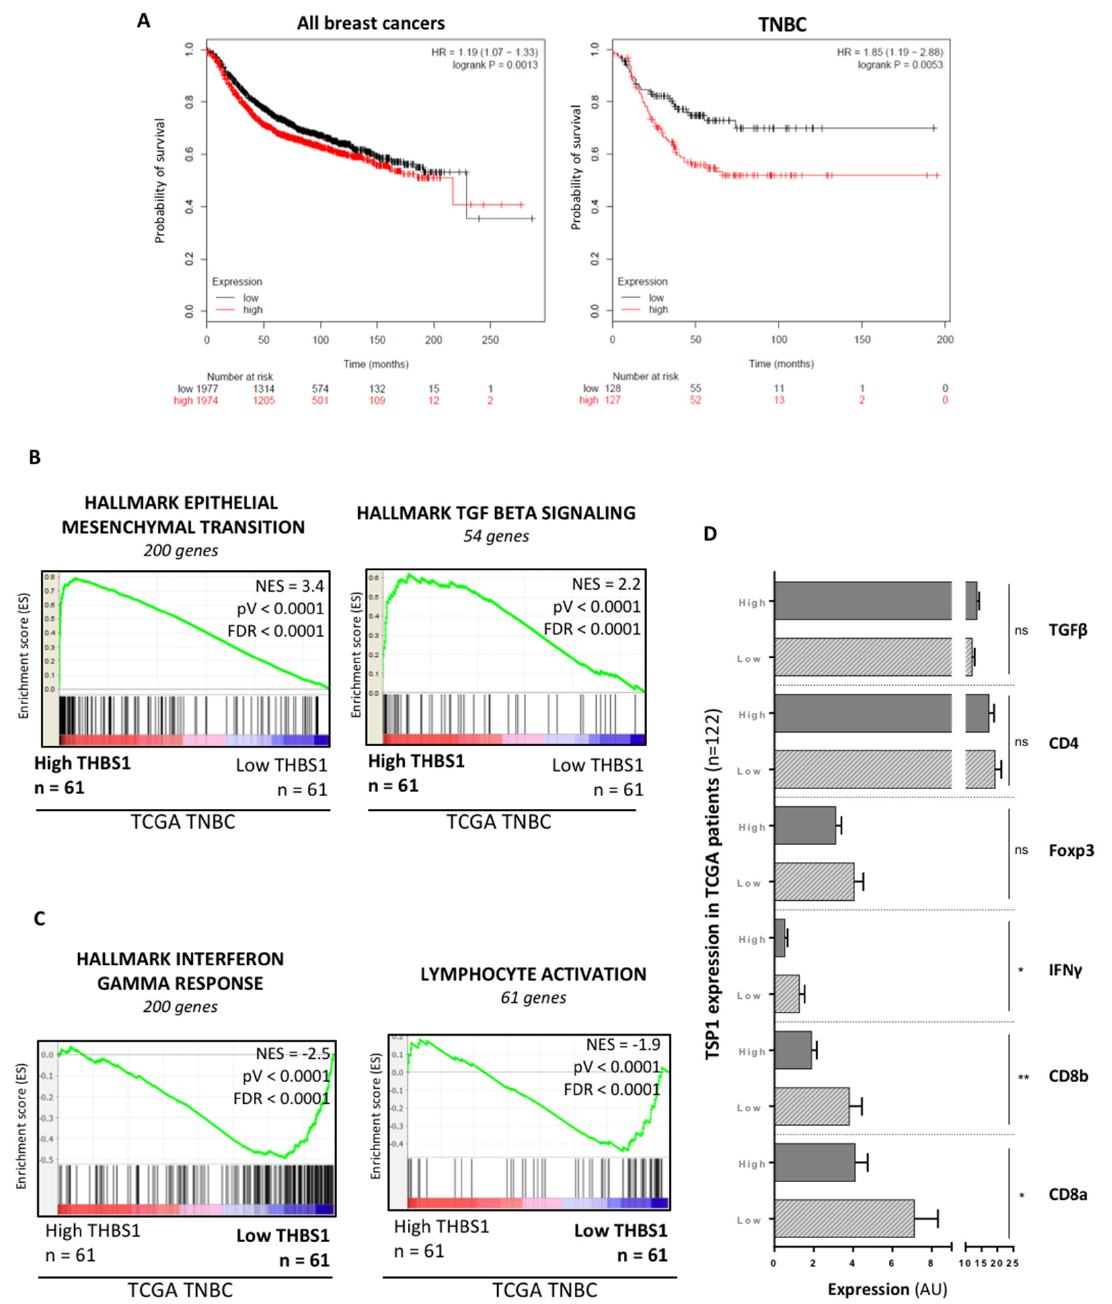
Figure 1. Impact of TSP1 expression on prognostic value in breast cancer. Schemes follow the same formatting. ( A ) Kaplan–Meier relapse-free survival analysis relating to TSP1 mRNA levels in 3951 breast cancer patients (left panel) and the same analysis in a cohort of 253 TNBC patients (right panel). Hazard ratios (HRs), 95% confidence intervals and log rank p -values are indicated in the graphs. ( B , C ) Gene Set Enrichment Analysis of gene signatures was performed from transcriptomes of the human TNBC TCGA database. Kolmogorov–Smirnov statistical test was performed. ( D ) mRNA expression in low and high TSP1 mRNA-expressing tumor samples from the human TNBC TCGA database. Mann–Whitney statistical test was performed. *, p < 0.05; **, p < 0.01; ns, not significant. Abbreviations: AU, Arbitrary Units; CD4, cluster of differentiation 4; CD8a, cluster of differentiation 8a; CD8b, cluster of differentiation 8b; FDR, false discovery rate; Foxp3, forkhead box protein P3; HR, Hazard Ratio; IFN γ , interferon γ ; NES: normalized enrichment score; TGF β , transforming growth factor β ; TNBC, triple-negative breast cancer; TCGA, the cancer genome atlas; TSP1, Thrombospondin-1.